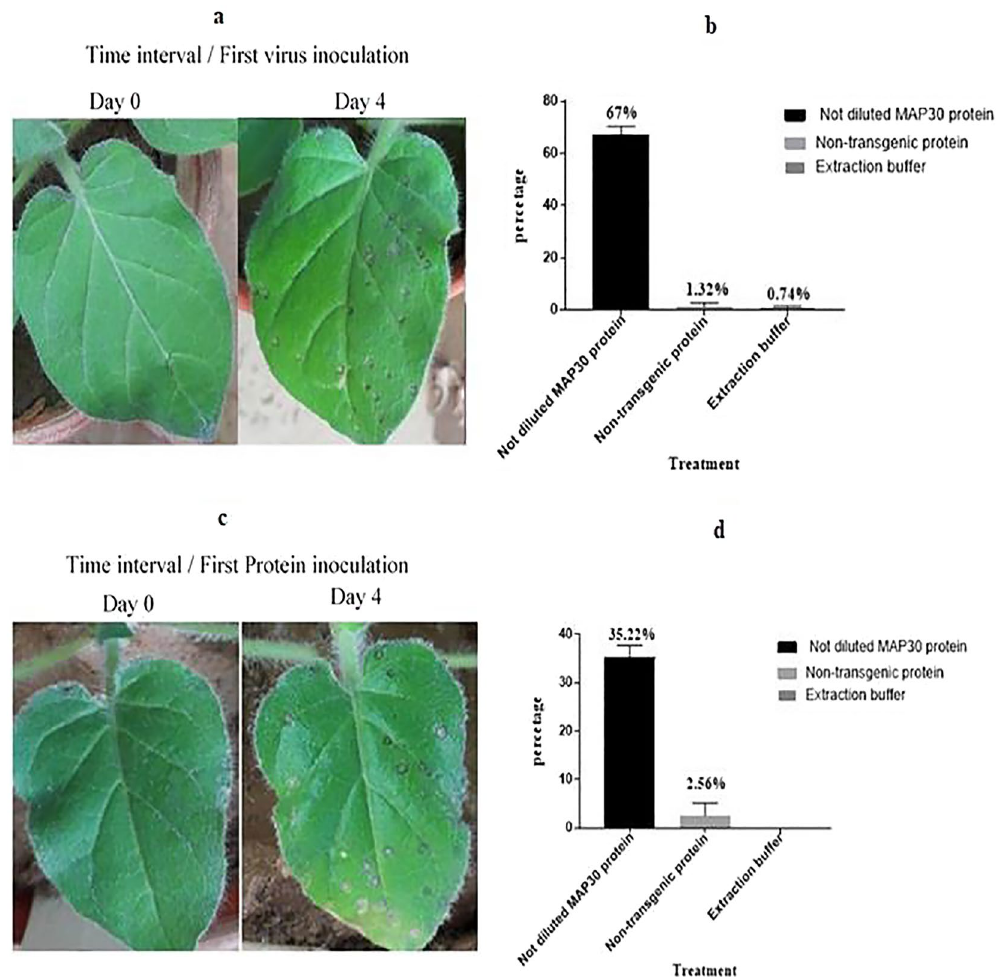
Figure 8. The inoculation of N. glutinosa seedling in the two-time interval assay with TMV and rMAP30 (Table 3). There were 8 replicates for each test . (a,b) The primary incubation with viral infection for a 6 h, then apply rMAP30 on the leaves surface. (c,d) The primary incubation of rMAP30 for 6 h, then apply viral infection on the leaves surface; D0 and D4, and D7 respectively indicate the day of applying the treatment either day, 4, and 7 days after the treatment It has been shown that the higher infection control observed when viral incubation have done 6 h prior than rMAP30. However, the control percentage in the initial treatment assay with rMAP30 is also significant and the number of viral spots is